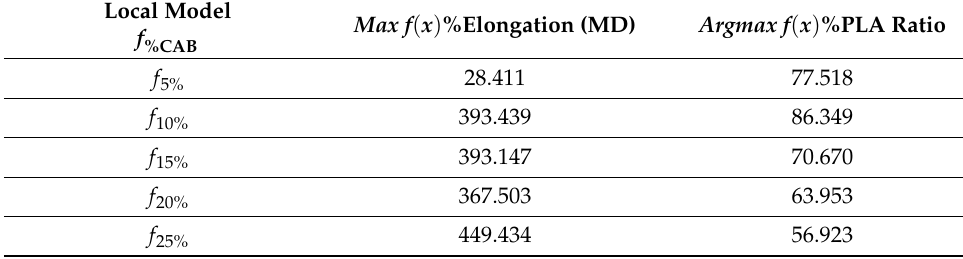
Table 3. The local models